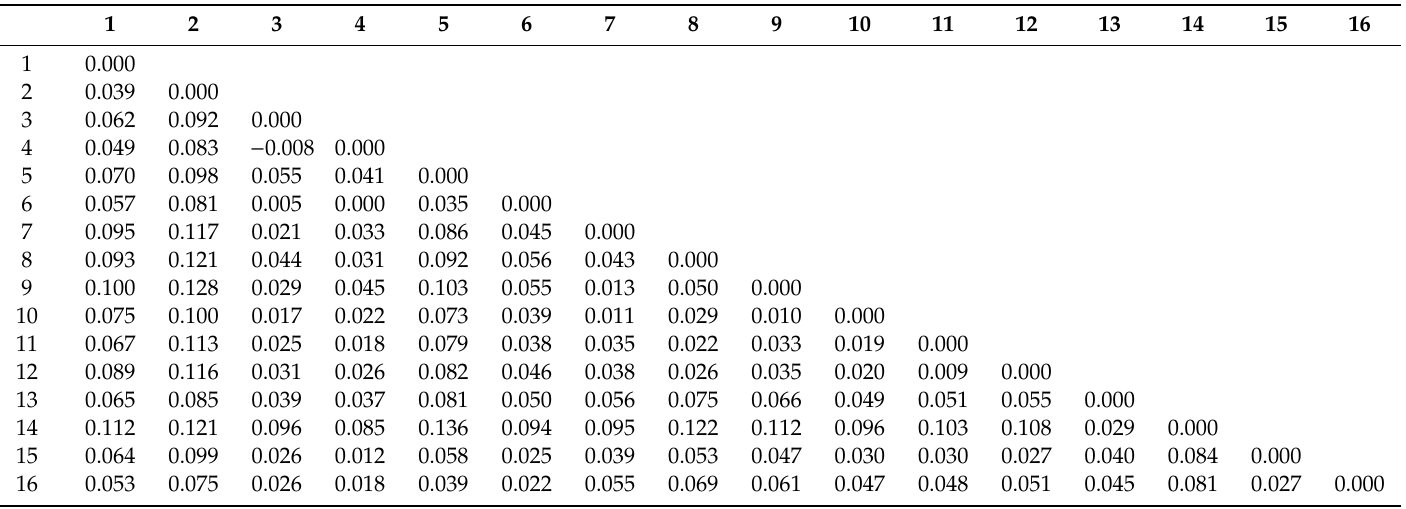
Table 6. Matrix of F ST metrics of differentiation among all striped bass collections: (1) Lake Marion, (2) Lake Moultrie, (3) Neuse River, (4) Tar River, (5) Cape Fear River, (6) Roanoke River, NC, (7) Smith Mountain Lake, (8) Leesville Lake, (9) Staunton River, (10) Kerr Reservoir, (11) Lake Gaston, (12) Roanoke Rapids, (13) James River,